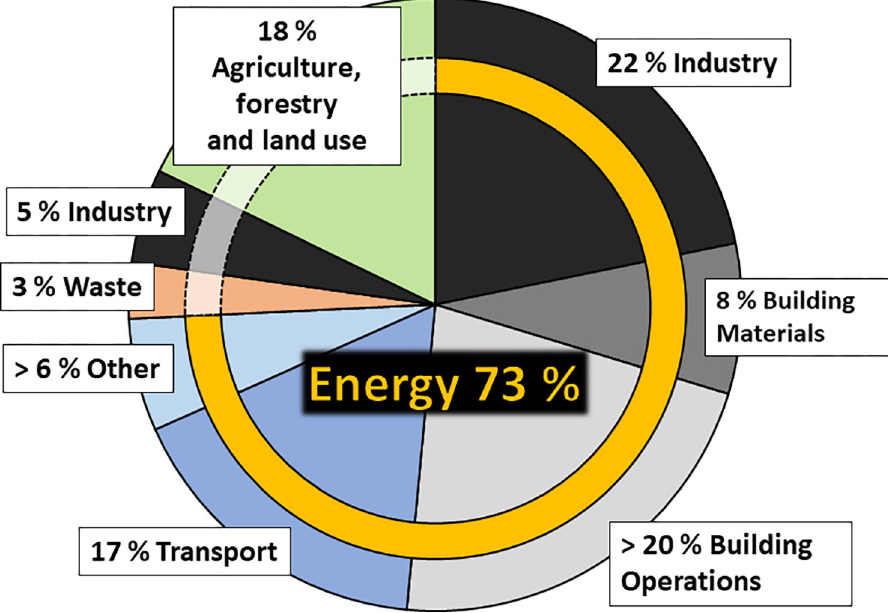
Fig 3. Global CO 2 emissions divided by respective sectors. The transport sector, specifically, results in 17% of emissions. Adapted from Ritchie and colleagues (2020), Carbon Leadership Forum 2020